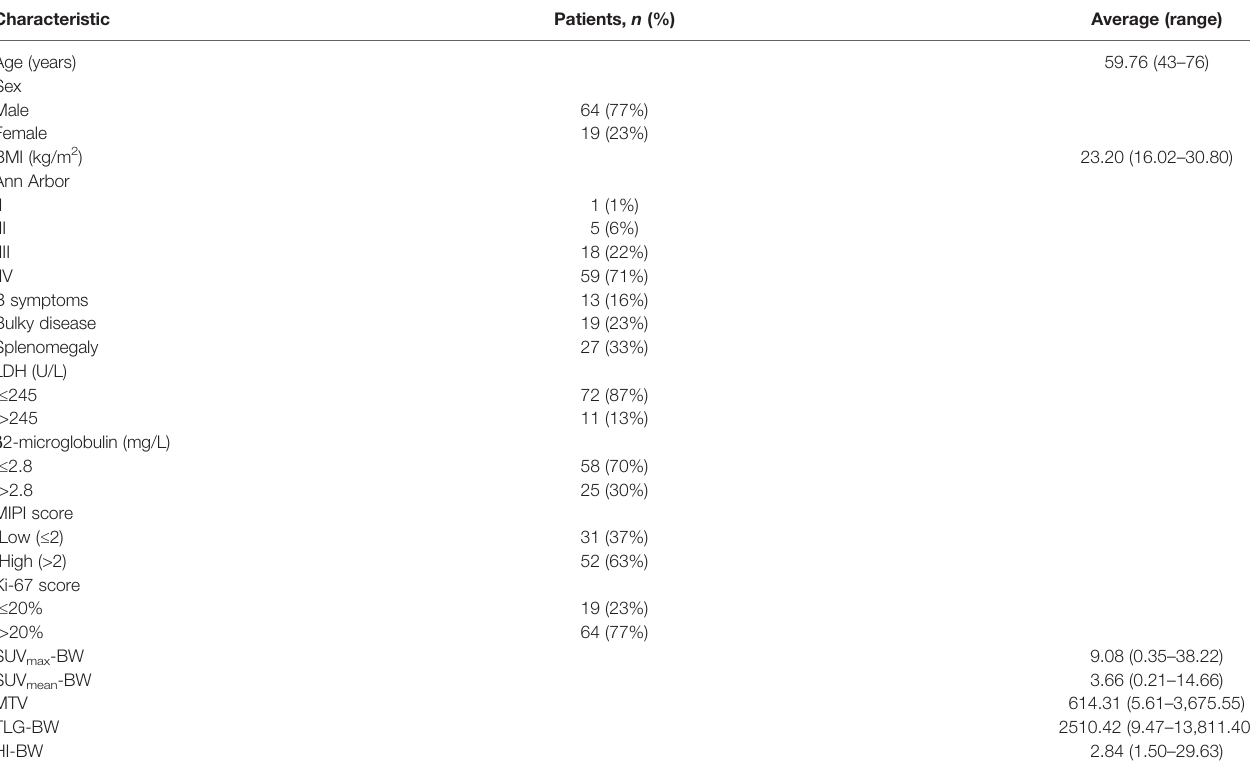
TABLE 1 | Baseline characteristics of patients ( n =